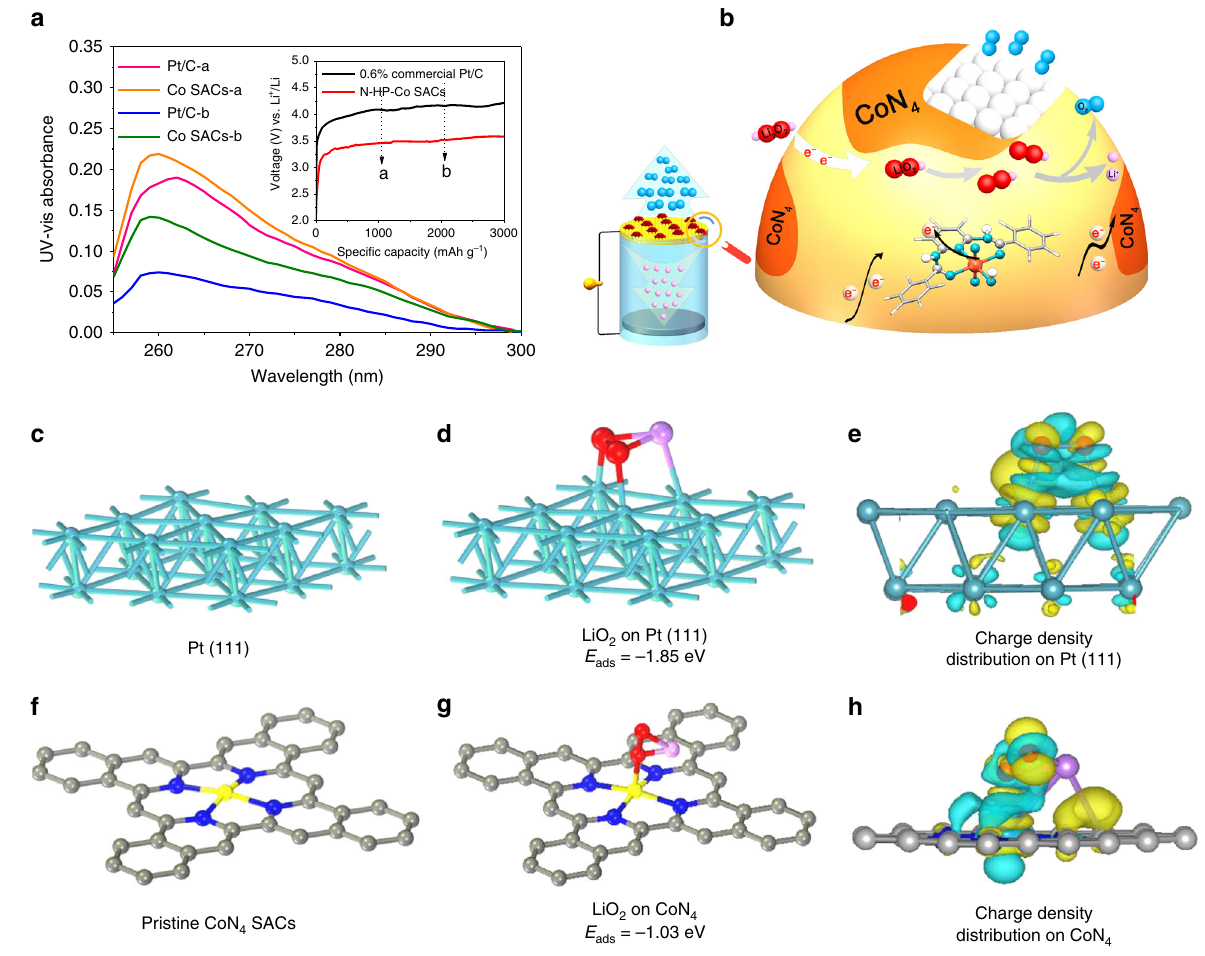
Fig. 5 Charge characterization. a UV-vis spectra of DMSO-extracted superoxide products from the 0.6% commercial Pt/C and N-HP-Co SAC cathodes at different charging states ( a state a, charge to 1000 mAh g − 1 ; b state b, charge to 2000 mAh g − 1 ). The inset of a shows the corresponding charge potential pro fi les of the Li − O 2 cells using 0.6% commercial Pt/C and N-HP-Co SACs at a current density of 100 mA g − 1 . b Schematic illustration showing the charge mechanisms of the N-HP-Co SAC-catalysed Li – O 2 batteries. c , d Pristine and top views of the optimized structures with the corresponding binding energy of LiO 2 on Pt (111); f , g optimized structure and the corresponding binding energy of LiO 2 on CoN 4 ; and e , h corresponding charge density distribution. Colour code: platinum (green), carbon (grey), CoN 4 (blue), and LiO 2